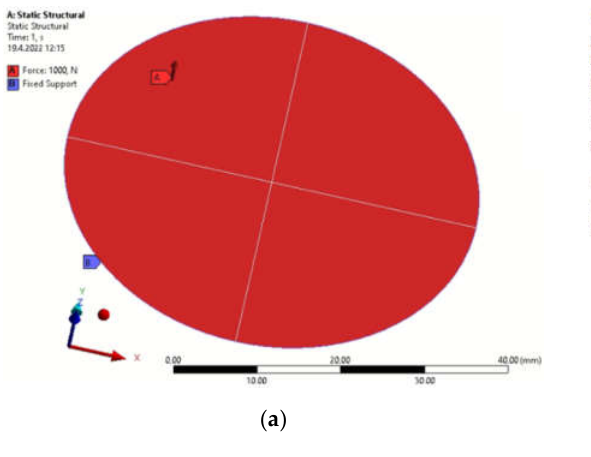
Figure 13. Geometric characteristics, boundary conditions and material properties ( a ) FEM pro- gram; ( b ) MATLAB. ( b ) MATLAB.